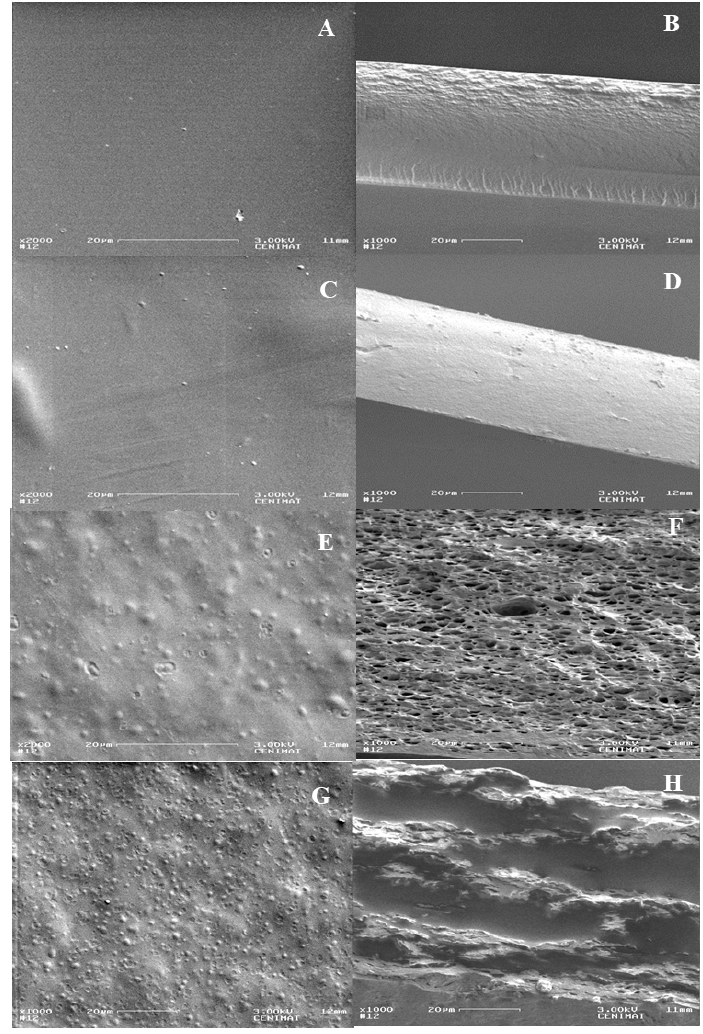
Figure 3. Scanning electron microscopy micrographs of surface and cross-section, respectively: chitosan film ( A and B ), chitosan film + MMT ( C and D ), chitosan film + 2% GEO ( E and F ), and chitosan film + MMT + 2% GEO ( G and H ).